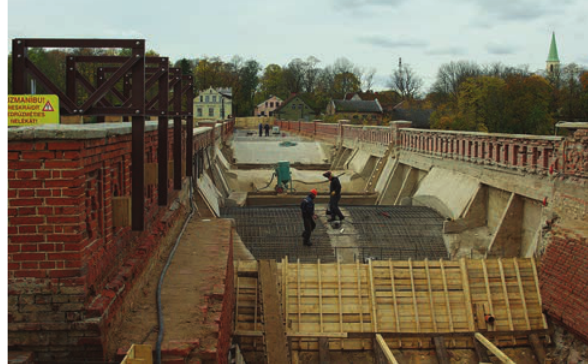
Fig. 11. Strengthening of the reinforced concrete arch span